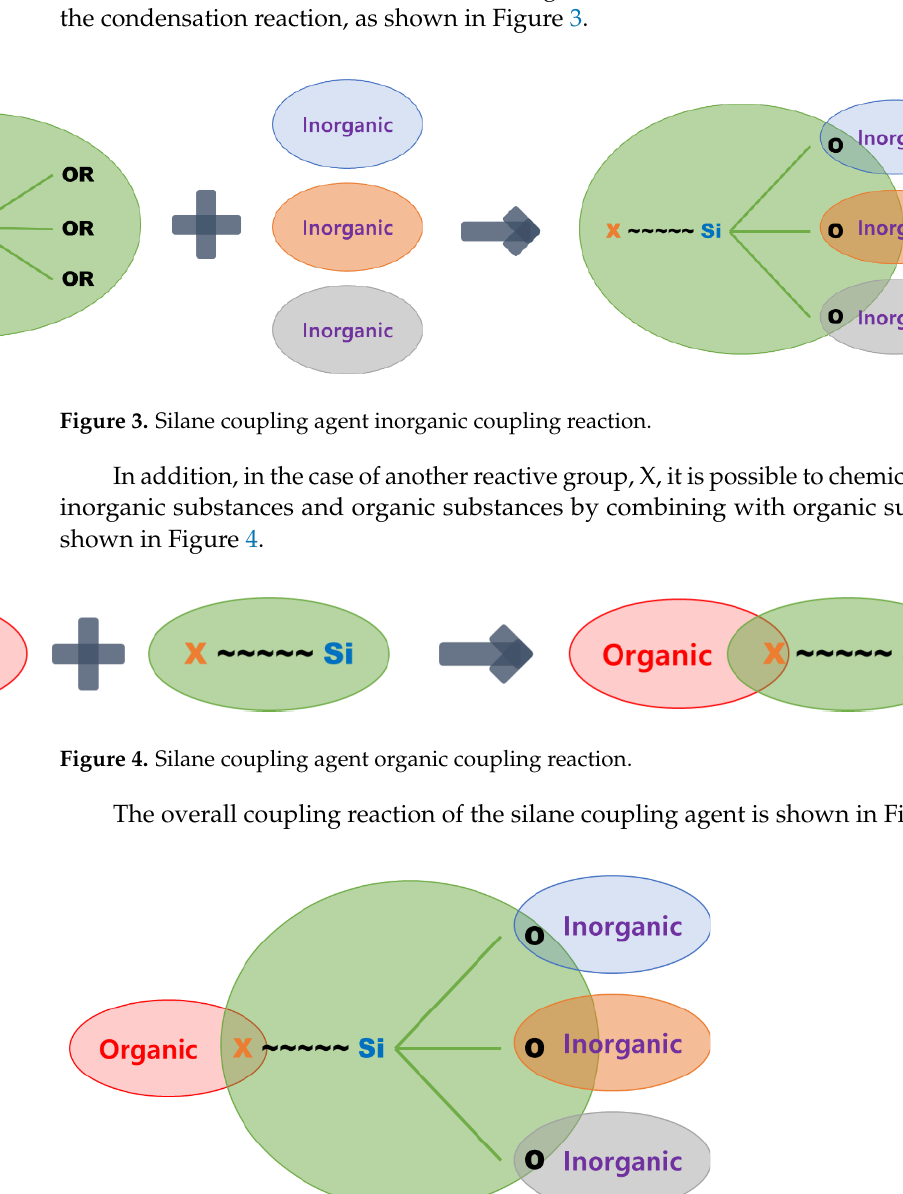
Figure 5. Total coupling reaction of silane coupling agent.